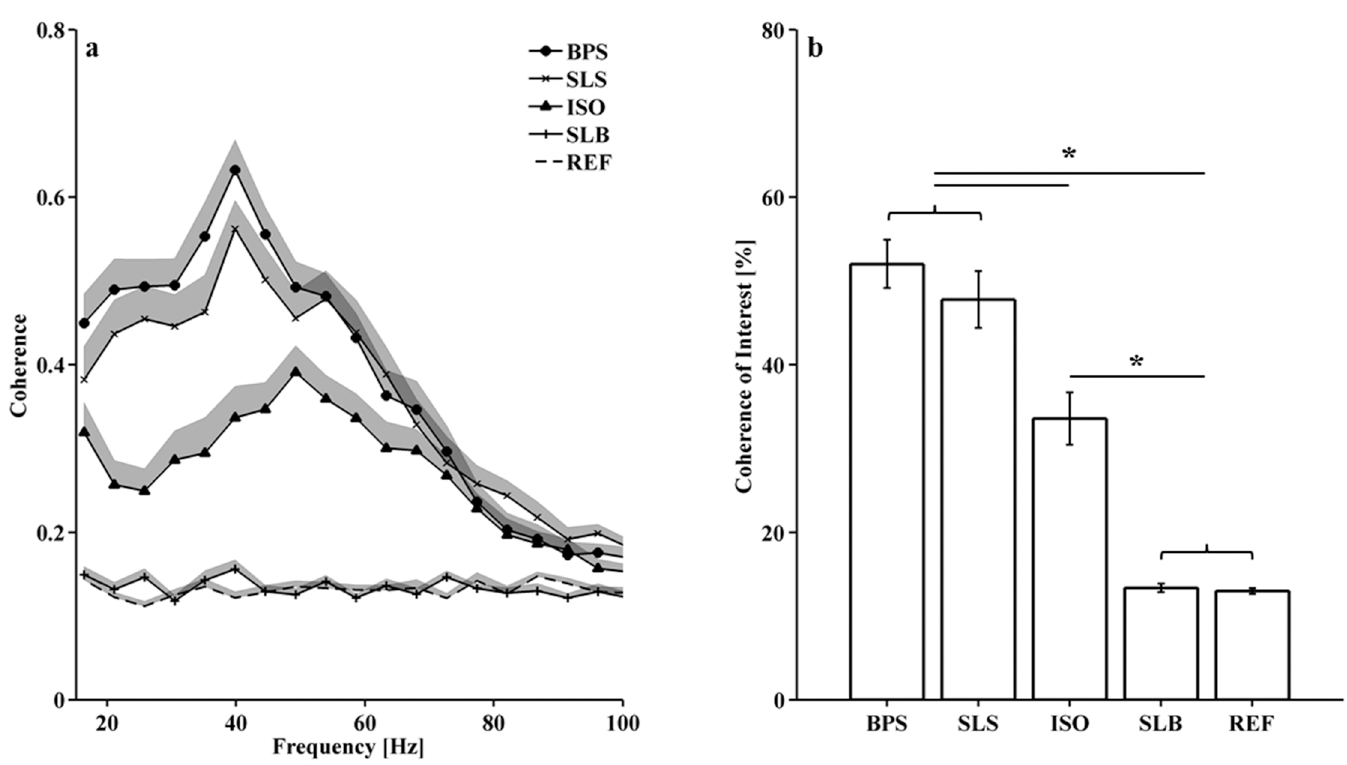
Fig 5. Task-dependent coherence between VM and VL EMG currents. Mean coherence spectra (+SE) (a) and coherence of interest ( ± SE) (b) across 16 participants for each task; asterisks indicate significant differences at α = 0.05.